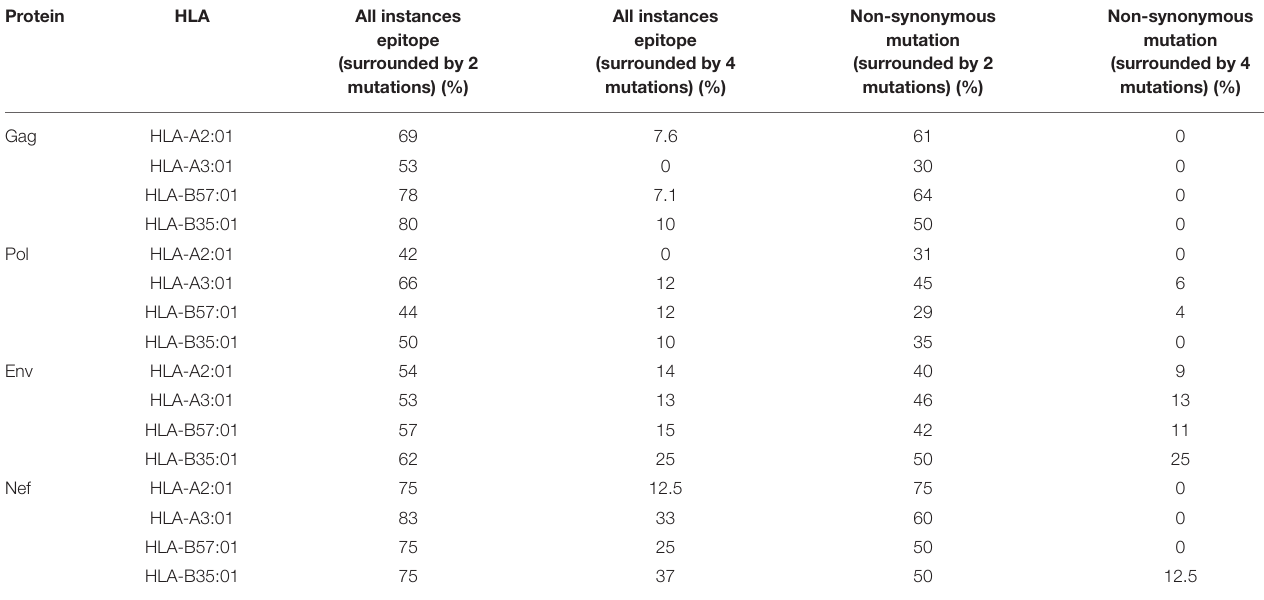
TABLE 3 | Enrichment of A3G hotspot motifs in flanking regions of sequence encoding CTL epitopes restricted to HLA-A2:01, HLA-A3:01, HLA-B57:01, and HLA-B35:01 for Gag, Pol, Env, and Nef. Protein HLA All instances